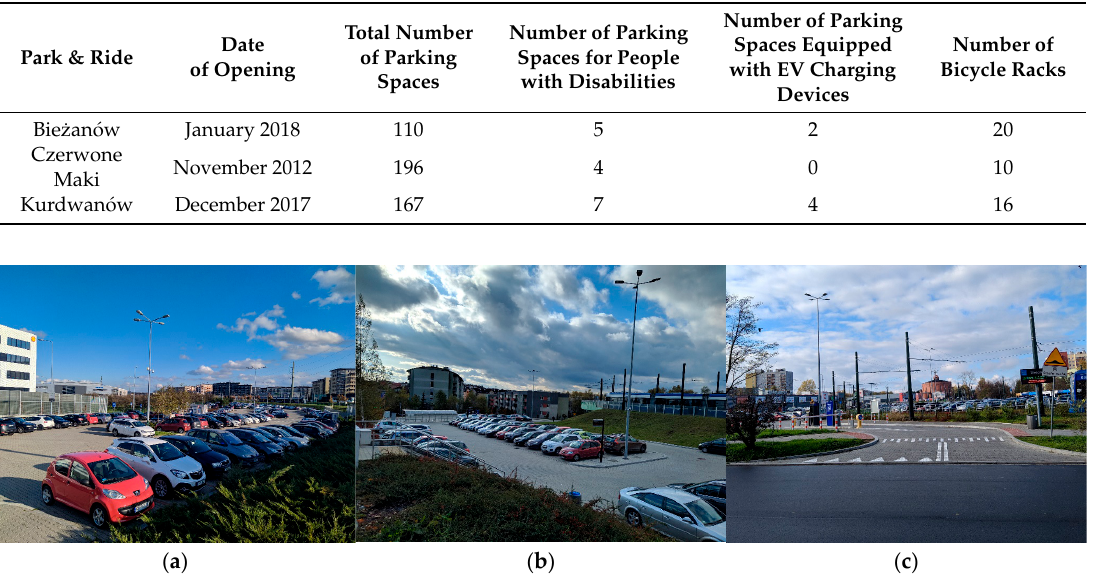
Figure 3. Views of the analyzed P&R parking in Cracow: ( a ) Czerwone Maki; ( b ) Kurdwanów; ( c ) Bie ż anów. Table 2. Possibilities of changing the means of transport in the analyzed P&R parking in Cracow. Parking P&